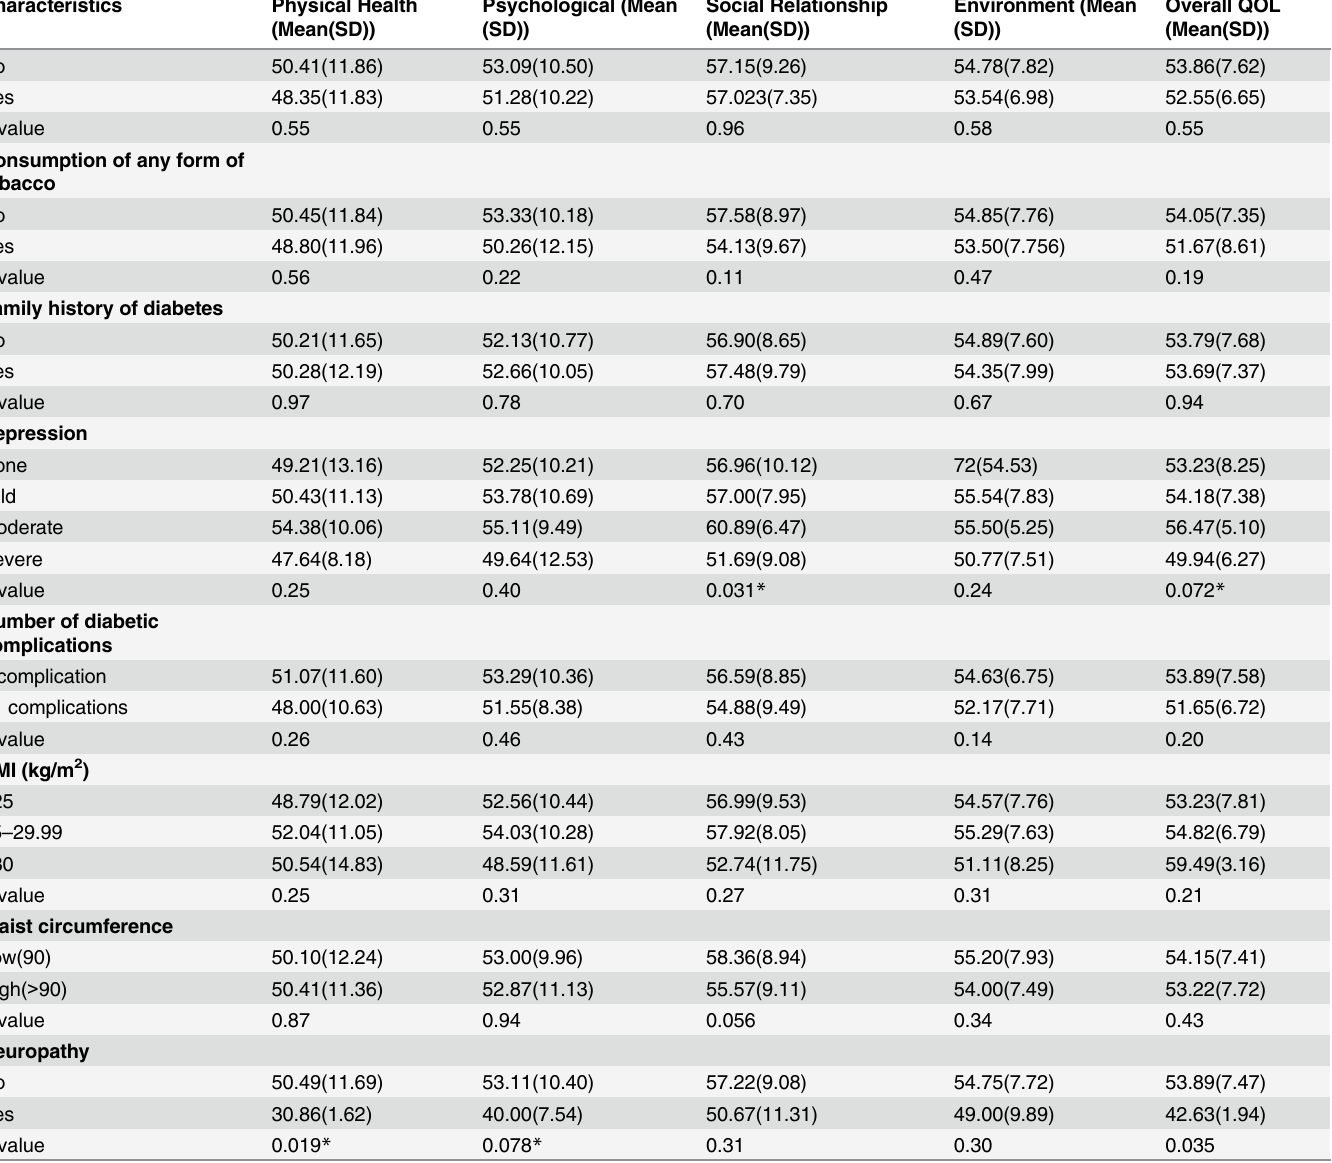
Table 6 presents the result of multivariate linear regression analysis. After adjusting for other covariates, having urban residence decreased the physical health score by 4.74 scores ( β = -4.74, 95% CI: -8.66, -0.82) and social relationship domain score by 3.42 scores ( β = -3.42, 95% CI: -6.43, -0.41) and overall QOL by 2.77 scores ( β = -2.77, 95% CI: -5.30, -0.25). Having diag- nosed with diabetes since more than 10 years increased physical health by 5.18 scores ( β =